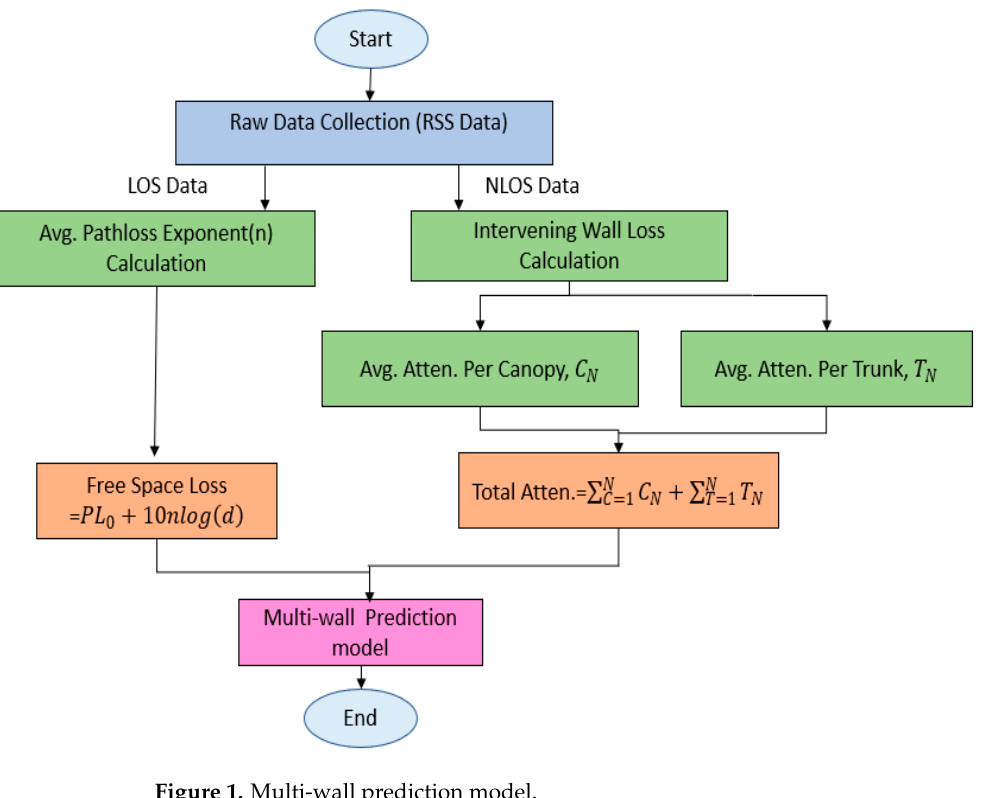
Figure 1. Multi-wall prediction model.